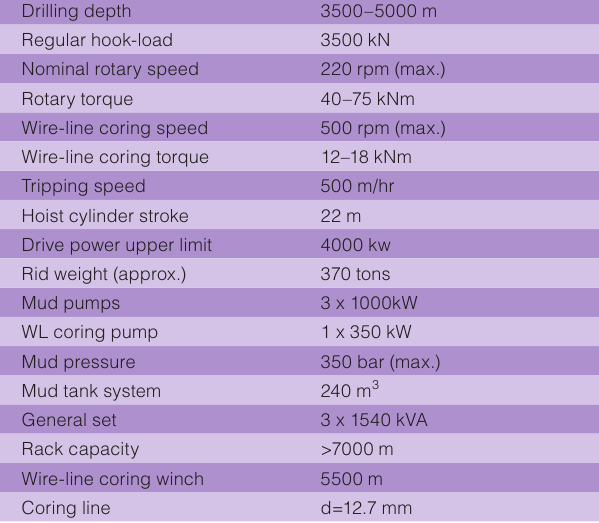
Table 1. Technical specifications of Innova